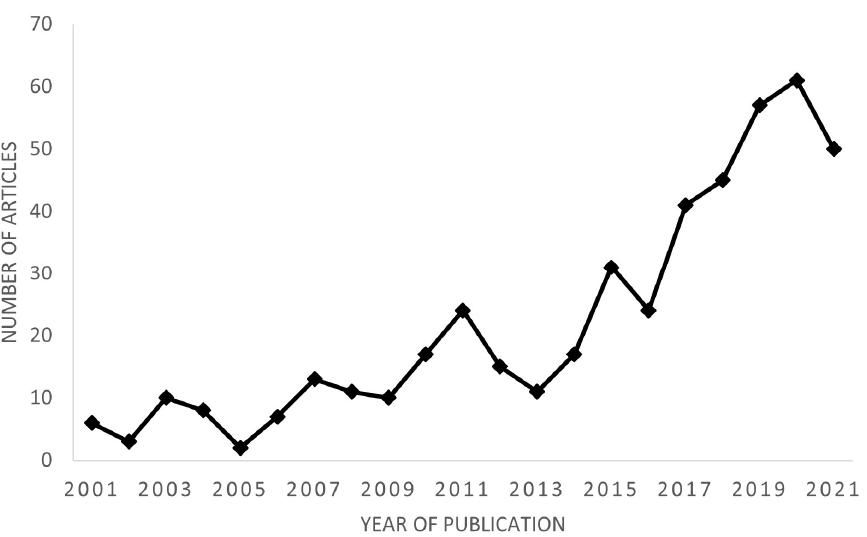
Figure 1. Number of articles published on natural or plant antioxidants in meat and meat products in the last 20 years (extracted from Web of